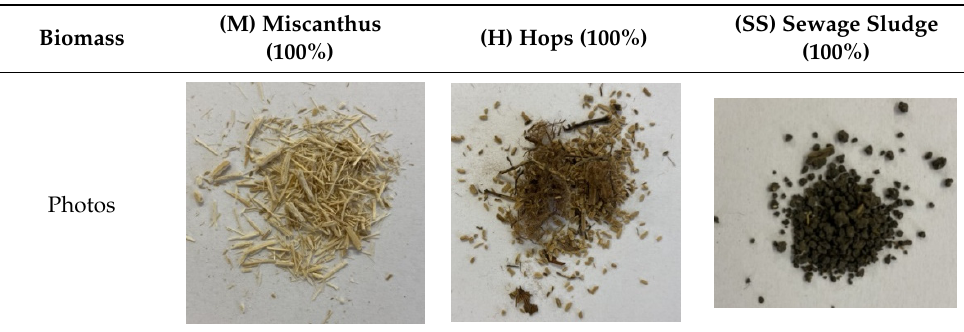
Table 2. Physical appearances of raw and torrefied biomass materials.